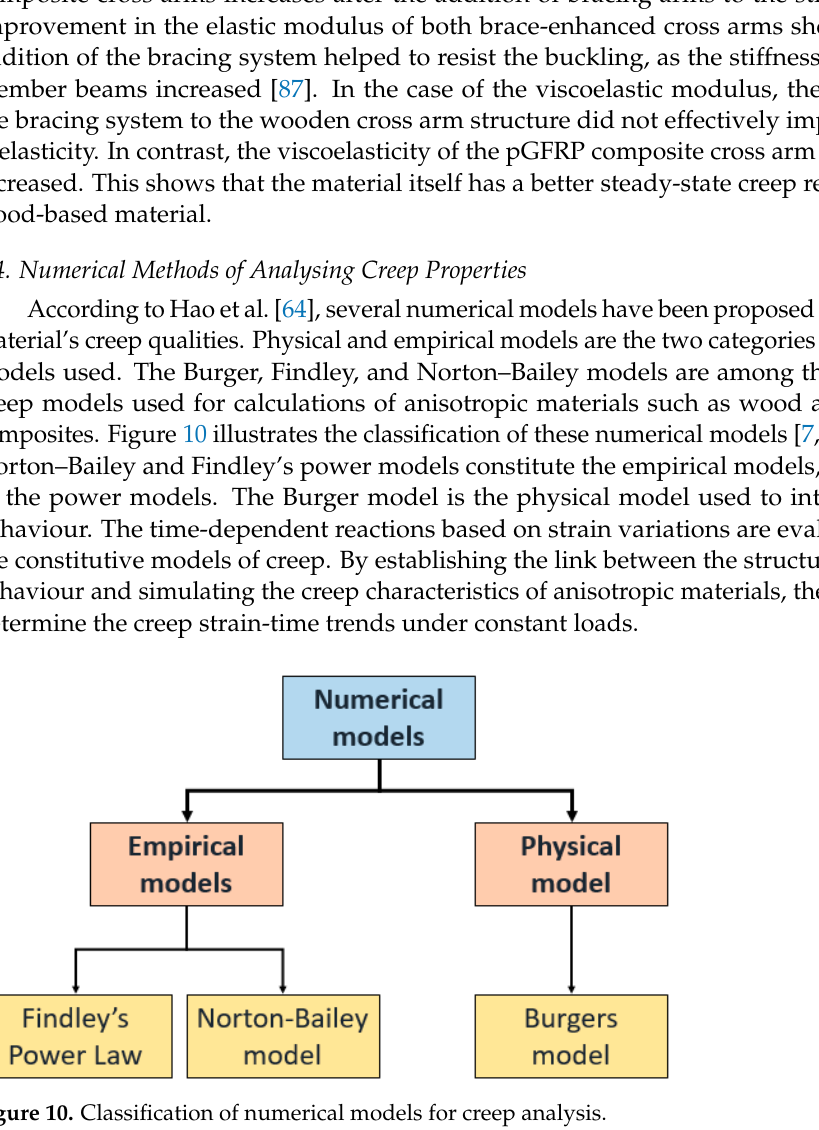
Table 7. Creep properties of wooden and pGFRP composite cross arms at the middle main member, y3.